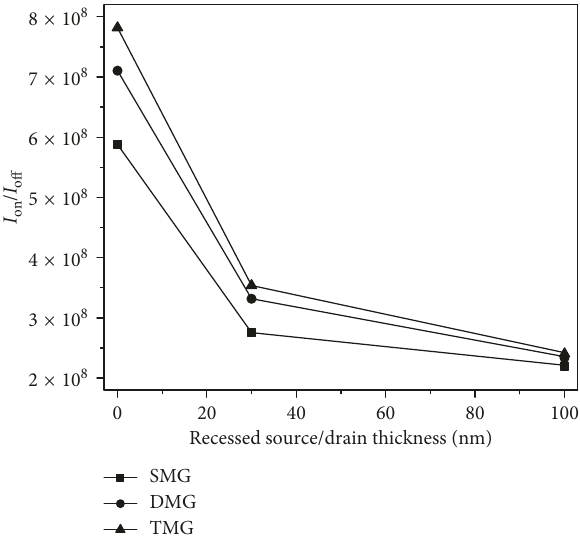
Figure 11: I on / I off for SMG, DMG, and TMG Re-S/D SOI MOSFET versus Re-S/D